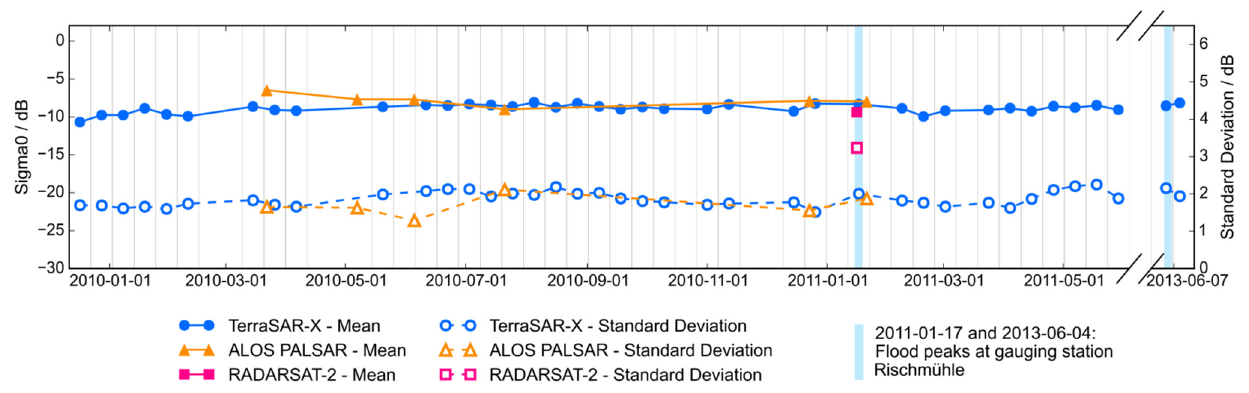
Figure 6. Time course of σ 0 (dB): Mean and standard deviation for test class 3 (Deciduous forest, dense,